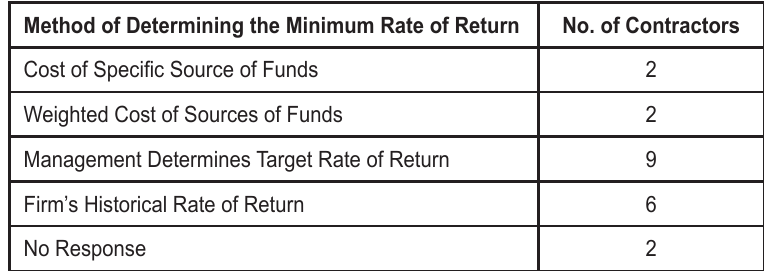
Table 6: Determination of the minimum rate of